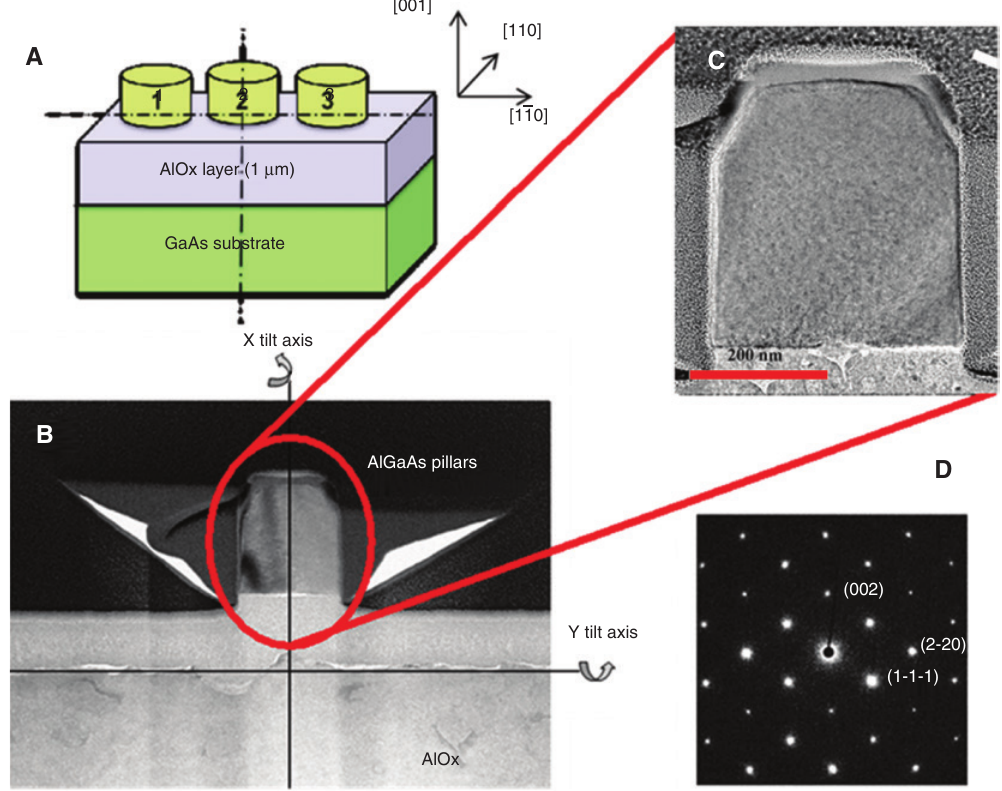
Figure 4: (A) Scheme of the sample for TEM prepared by FIB and (B) TEM picture of AlGaAs/AlOx nanoantenna 2, with indications of the crystalline rotations around the [001] ( X ) and [11̅0] ( Y ) axes. The brighter area is the AlOx layer, whereas the darker area surrounding the pillar is platinum. (C) High-resolution detail of Figure 4B and (D) electron diffraction pattern of nanoantenna